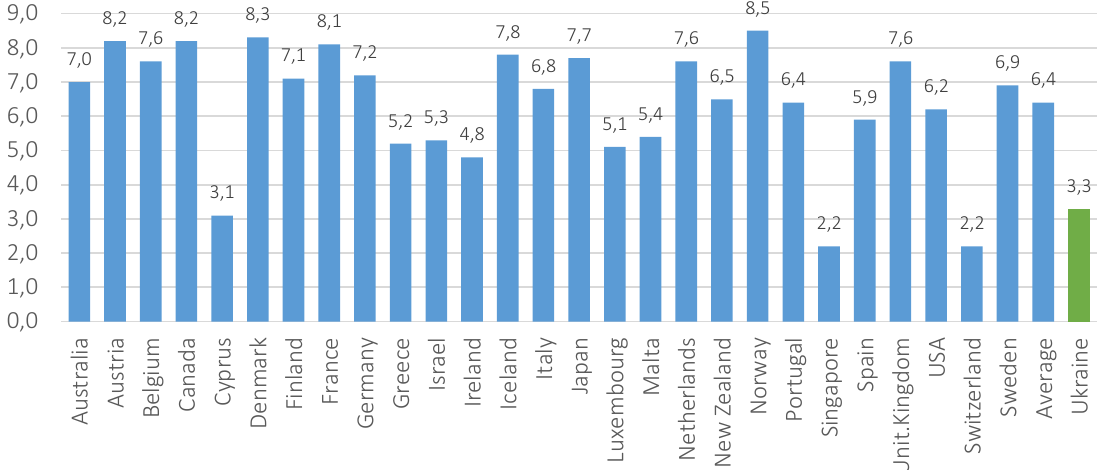
Figure 4. Public expenditure on health care in advanced economies and Ukraine as a % of the